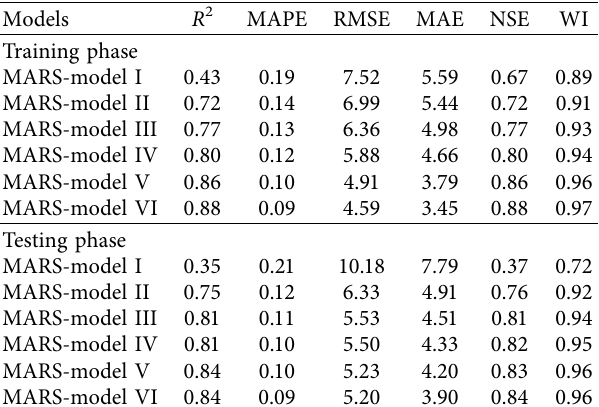
Table 10: Statistical measurements for MARS model over training and testing phase for all input combinations.